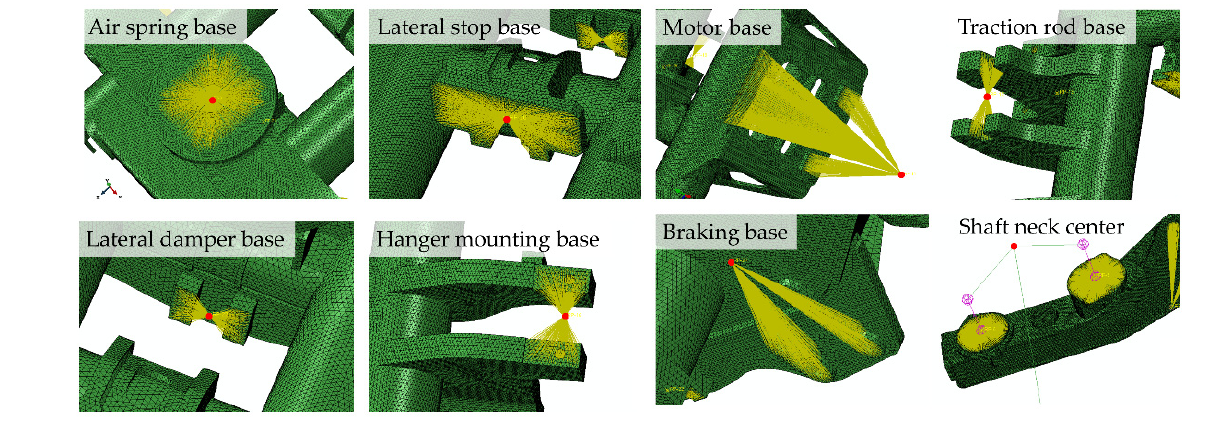
Figure 3. Load coupling reference point. Table 3. Load case summary.